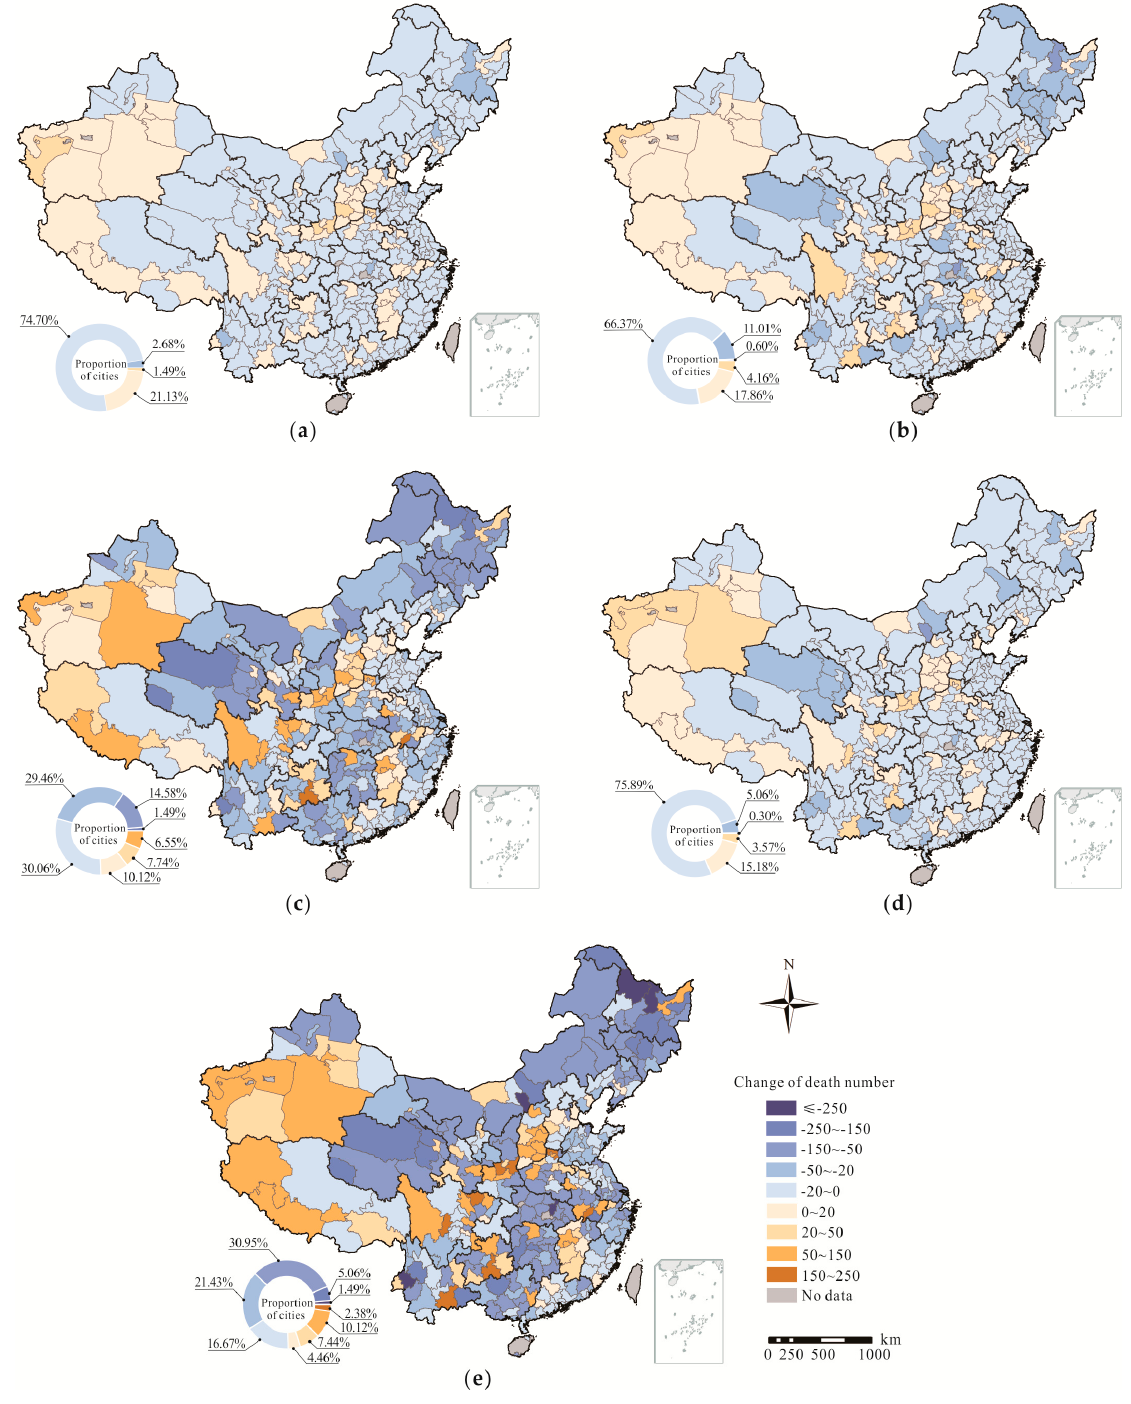
Figure 5. Distributions of changes in ( a ) LC deaths, ( b ) IHD deaths, ( c ) stroke deaths, ( d ) COPD deaths and ( e ) total deaths from 2015 to 2016.